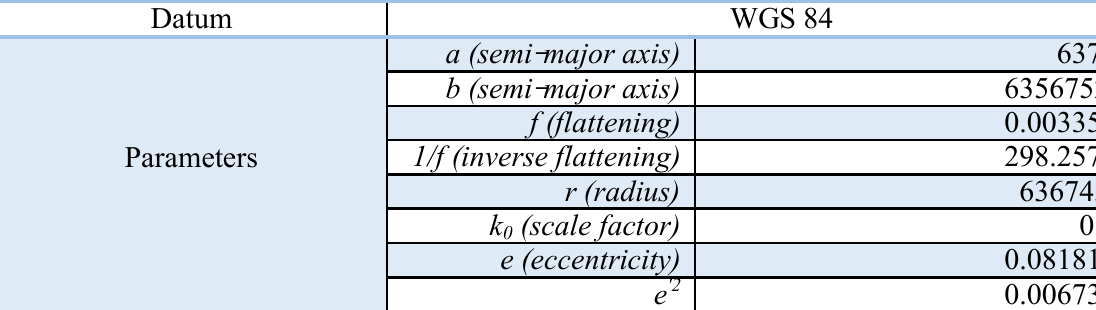
Table 1. Datum and Parameters of UTM projected coordinate